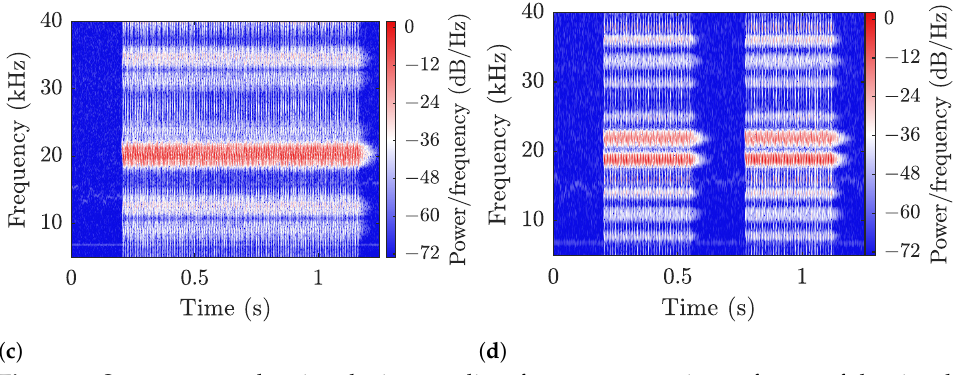
Figure 8. Spectrograms showing the intermediate frequency over time of parts of the signal to illustrate the effects of the channel and undersampling. ( a ) Single band signal after up-conversion before transmission; ( b ) Multi-band signal after up-conversion before transmission; ( c ) Single band after reception before down-conversion; ( d ) Multi-band after reception before down-conversion. Each package is transmitted three times in the experiment.